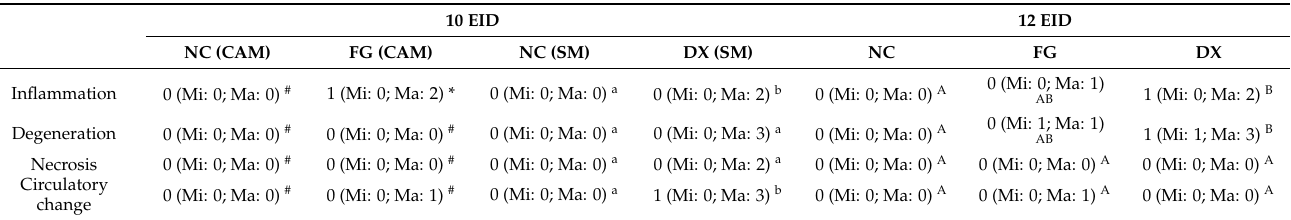
Different symbols on the same line indicate a statistical difference between FG and NC inoculated via CAM. Different lowercase letters on the same line indicate a statistical difference between DX and NC at inoculated via SM. Different uppercase letters on the same line indicate a statistical difference in CE inoculated at 12 EID ( p < 0.05). Mi: Minimum, Ma: Maximum. NC: Negative control. CAM: Chorioallantoic membrane. FG: